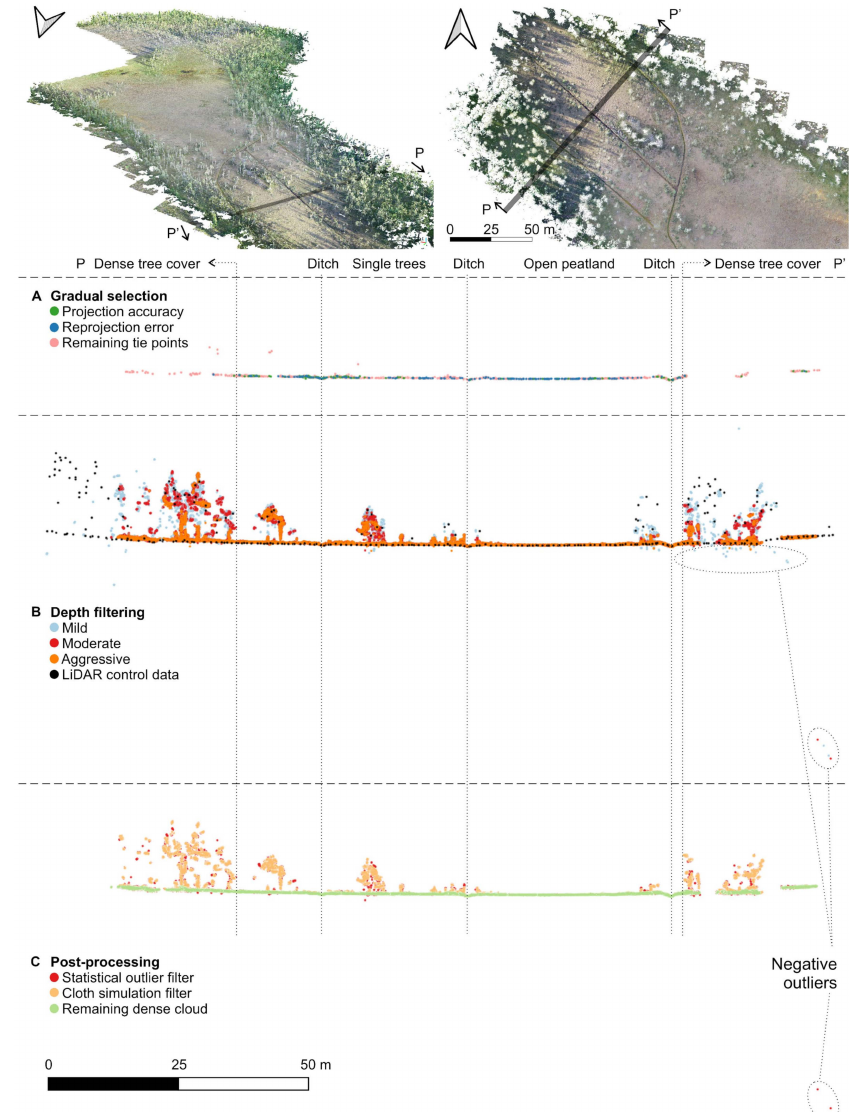
Figure 5. Impacts of different filtrations on the structure-from-motion (SfM) point clouds are visual- ized as orthometric crosscuts (3-metre wide slices for sufficiently accumulating points) for Loukkusuo site data. The slices with the fewest points are ordered closest to the viewer. The Gradual selec- tion filters of Metashape ( A ) remove the tie-points of poor quality (the reconstruction uncertainty filter did not influence the chosen slice). The level of depth filtration in the Metashape dense cloud creation ( B ) affects the vertical representation of the vegetation and the occurrence of outliers (the light detection and ranging (LiDAR) data shown as a reference). The post-processing filtrations applied in CloudCompare for the moderately-depth-filtered dense cloud ( C ) show Statistical Outlier Removal (SOR) performing well, removing the outliers, and Cloth Simulation Filter (CSF) removing the non-ground points. ( A , C ) show the incremental removal of points for the same dataset, whereas ( B ) compares the products from different settings of parallel processes. The scale bar represents both horizontal and vertical